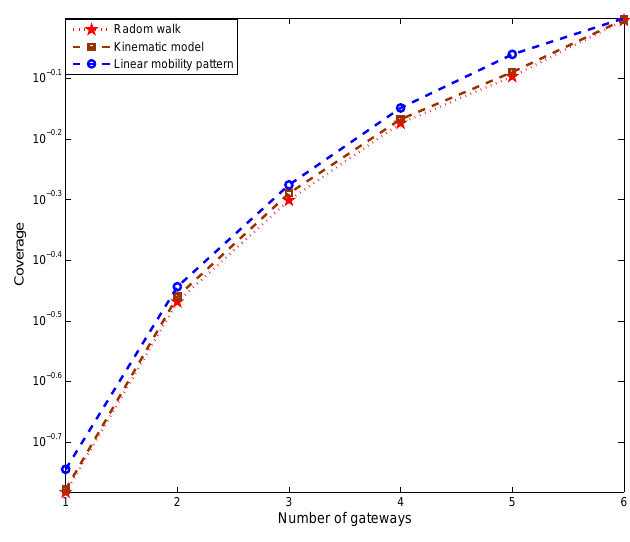
Figure 12. Impact of mobility pattern on coverage.